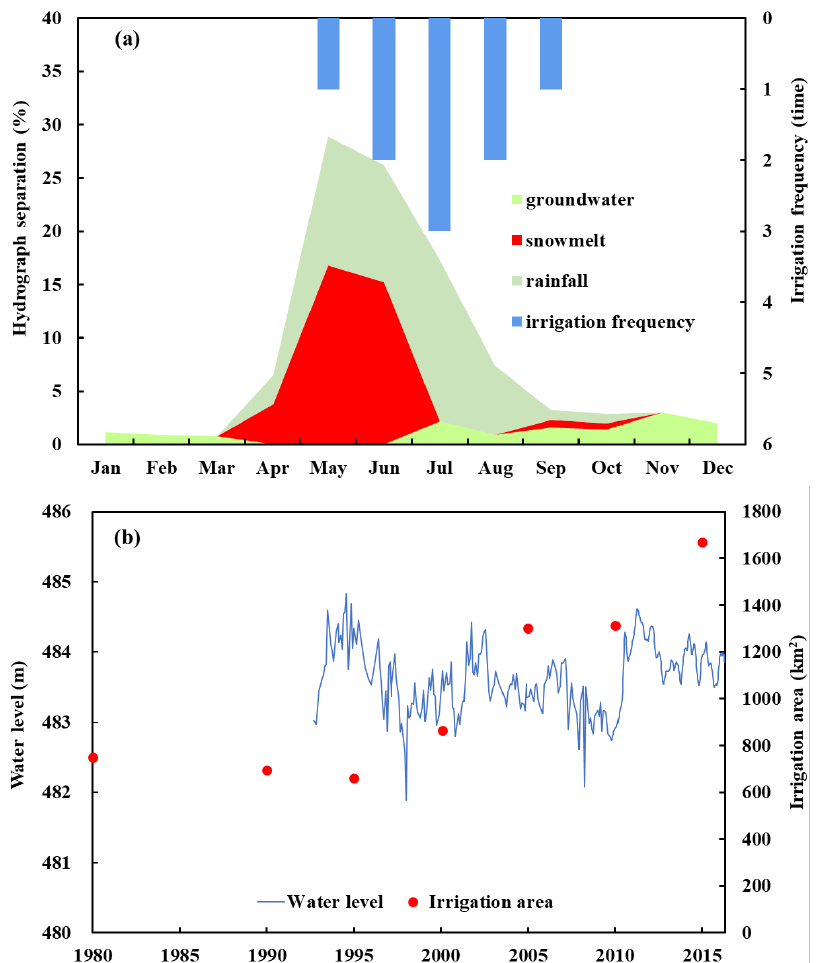
Figure 7. ( a ) Irrigation schedule (timing and frequency) for Edible sunflower (upper blue bars) and hydrograph separation of the various water sources in 2015 in the headwaters of the Irtysh River. ( b ) Variations in the Ulungur Lake water level during the period 1992–2015 (blue line) and cropland area in the Ulungur River Basin during the period 1980–2015 (red circles).